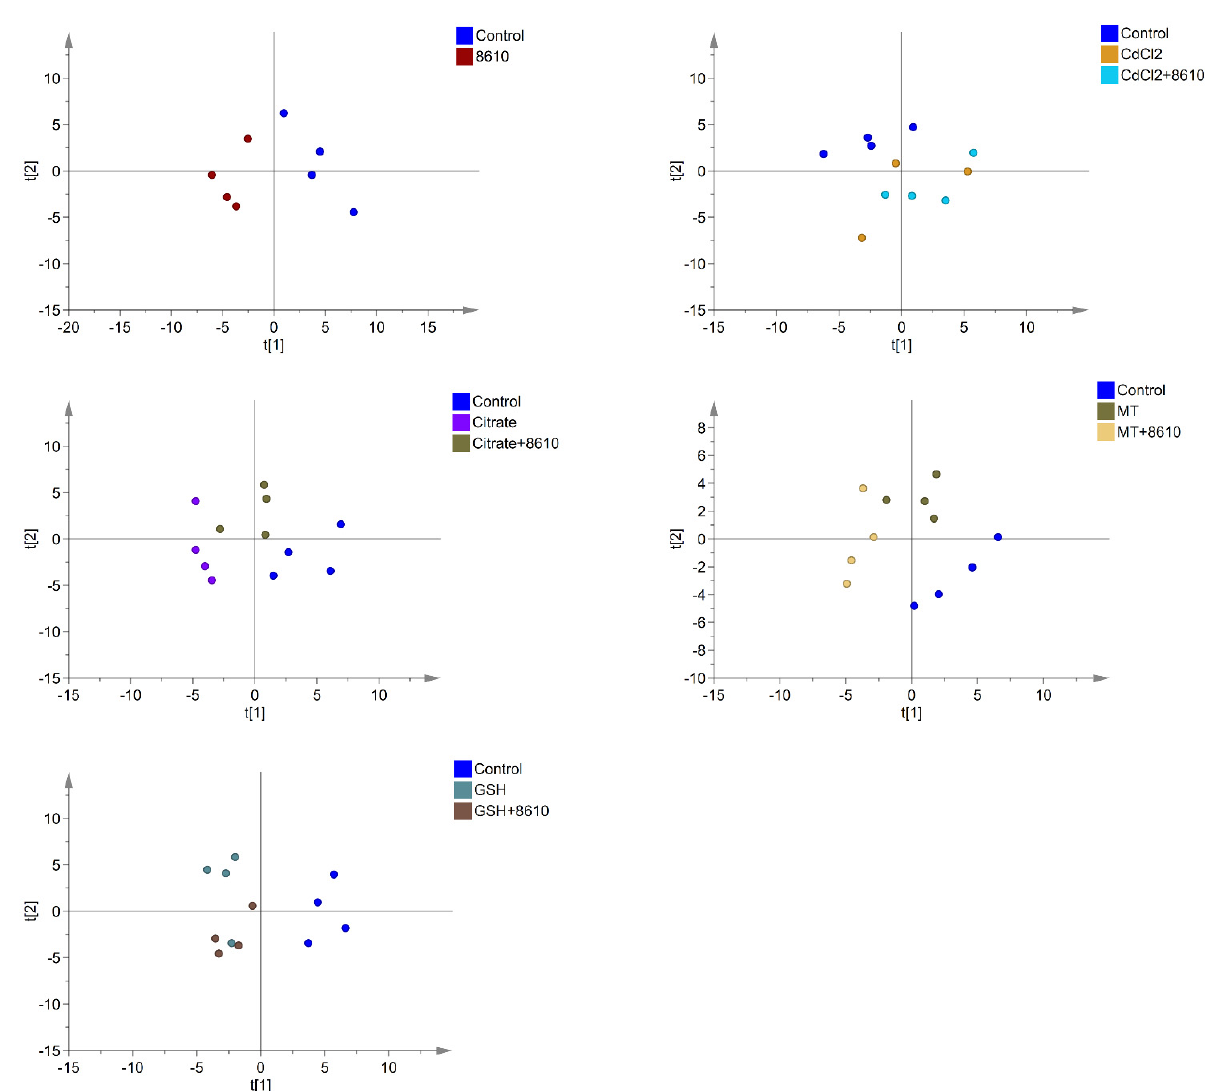
Figure 3. Microbiome multivariate analysis based on Principal Component Analysis (PCA) of fecal microbiota in mice.